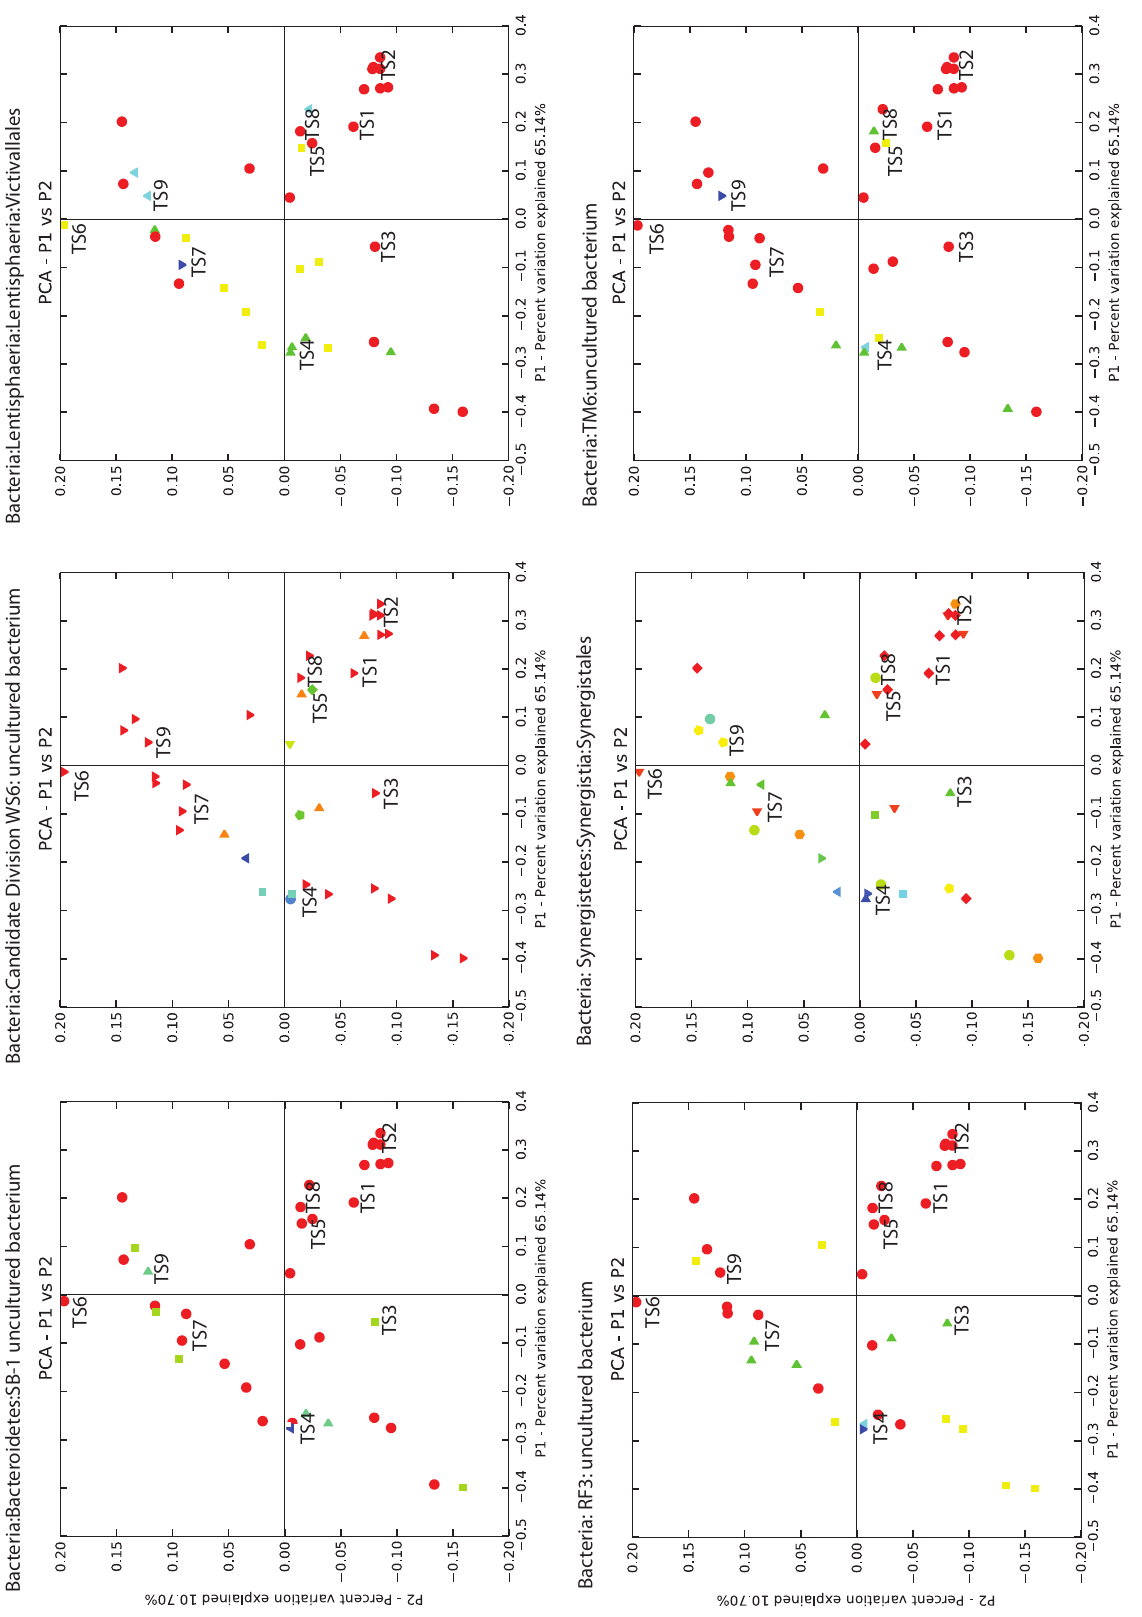
Figure 5. Microbial community principal coordinate analysis with highly correlated microbial groups coloured blue (high read count) to red (low read